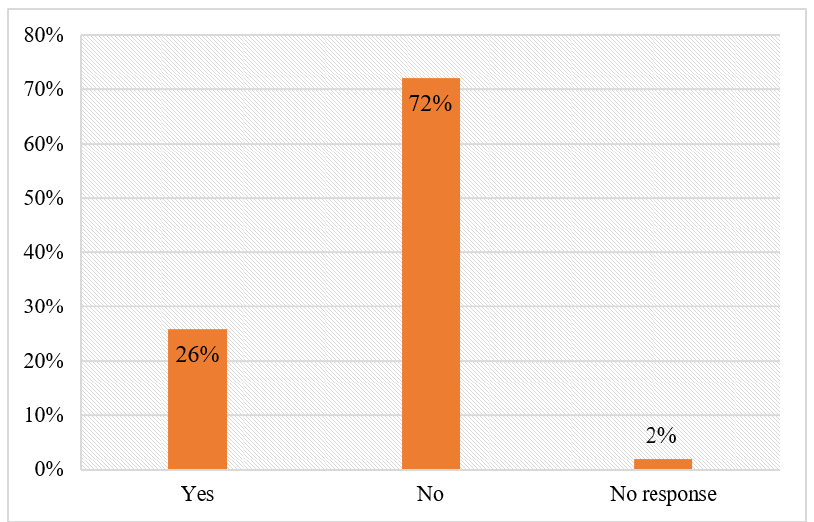
Figure 4. Support for the proposed mining of the forest reserve. Source: Field survey, 2021. Table 5. Reasons for supporting the proposed mining of the forest reserve. Reasons for Supporting Frequency out of 51 for Each